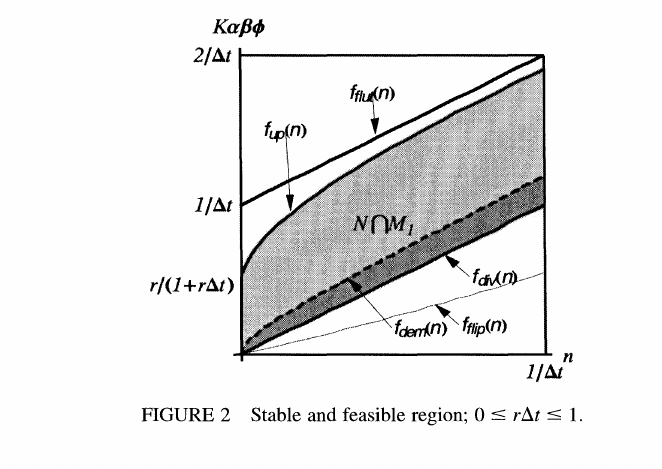
FIGURE 2 Stable and feasible region; 0 -< rat <-